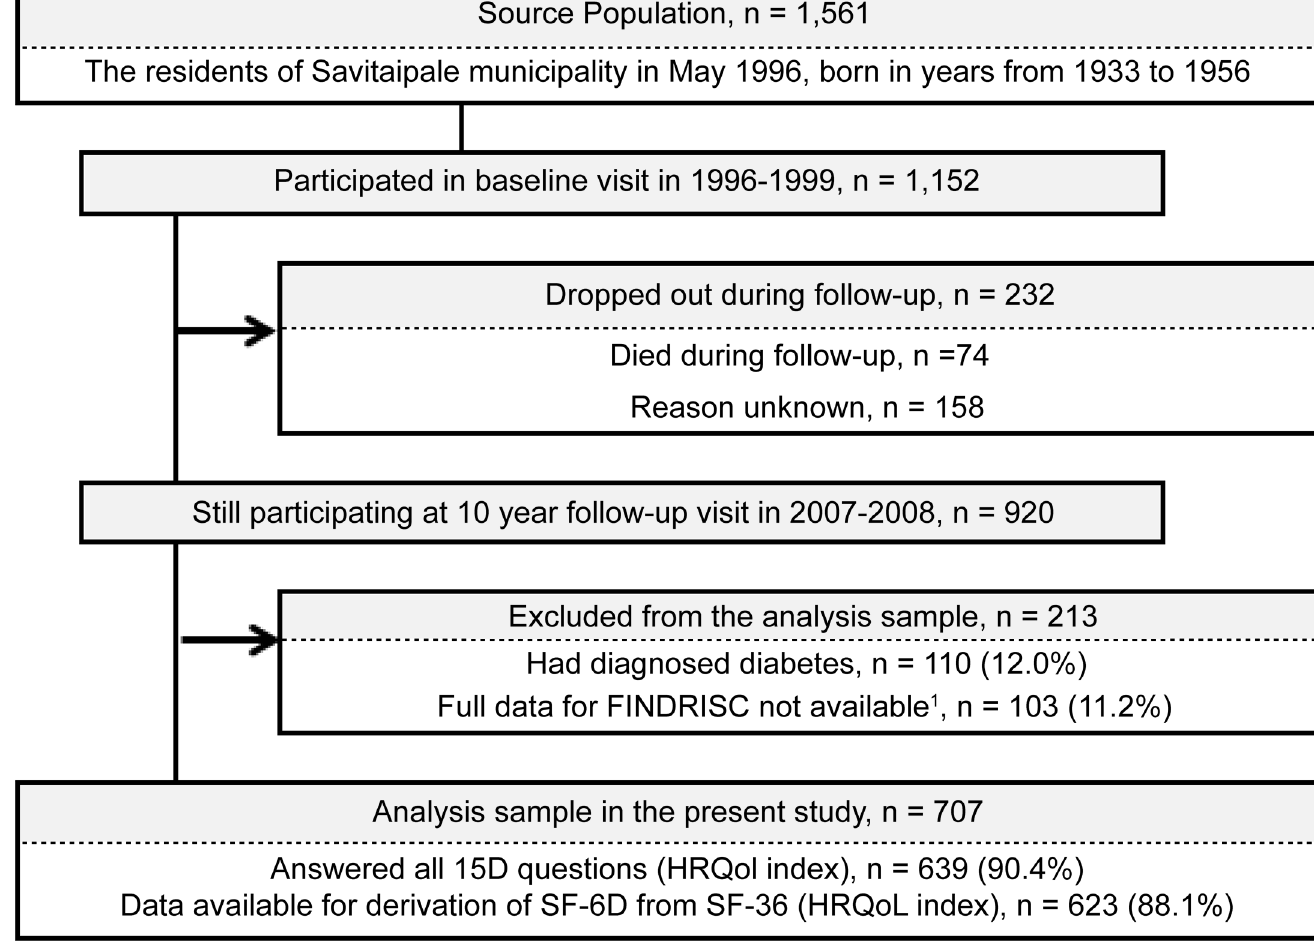
Fig 1. Flow diagram of the participants included in the study sample. FINDRISC: Finnish Diabetes Risk Score. 1) FINDRISC question regarding the consumption of fruits, berries and vegetables was omitted.